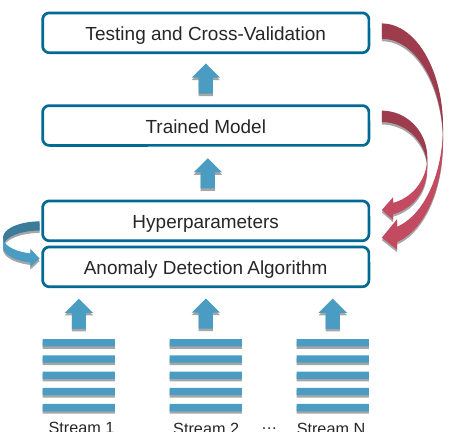
Figure 1. Hyperparameter tuning with resource trade-offs for an anomaly detection